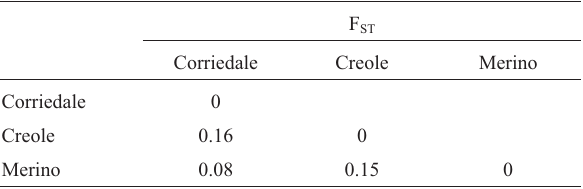
Table4 -Geneticdifferentiationbetweenbreeds,expressedasthefixation index (F ST ; Weir and Cockerham, 1984) using a subset of 18,181 auto- somal SNP